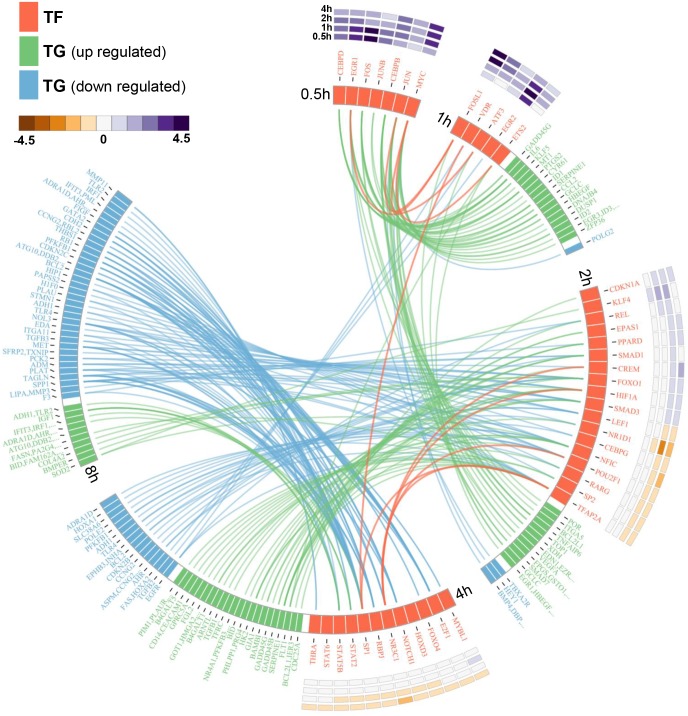
The transcriptional network during early adipogenesis.Using the adipogenesis time-course expression data [17], we identified differentially expressed genes (fold-change > 1.5, p-value < 0.05). Next, we combined differentially expressed genes from adjacent time-points (1h and 2h, 2h and 4h, etc), applying Application I to identify enriched TFs (p-value < 0.05). Combining two timepoints at a time provided sufficient resolution to observe rapid changes in TF activity. Enriched TFs that were differentially-expressed at the previous timepoint (e.g. at 0.5h, if enriched at 1-2h) were considered to be part of the transcriptional cascade. ORTI was used to identify the pairwise interactions that were subsequently used to construct the interaction network. This has been visualised using Circos [19]. The heatmap adjacent to each TF reflects their expression pattern over the time-course.